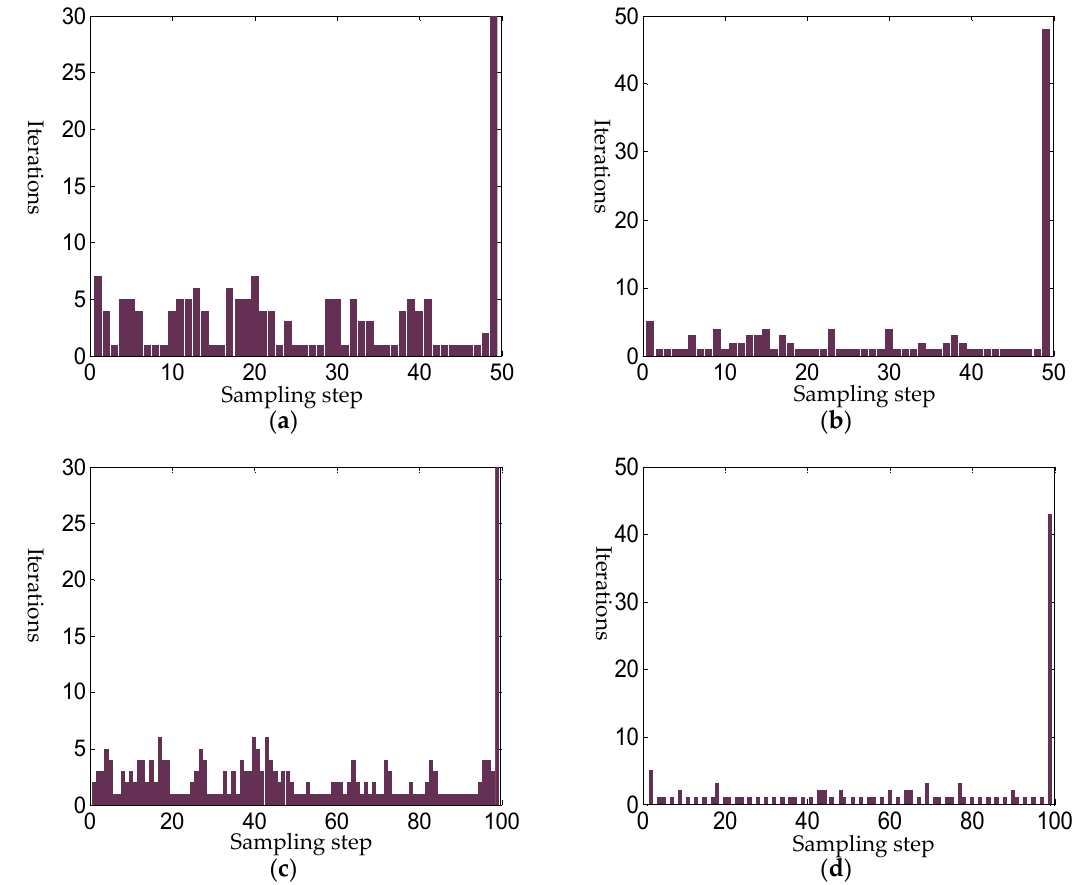
Figure 11. Iterations of the improved algorithm under different sampling conditions. ( a ) 50 steps uniform sampling tracking; ( b ) 50 steps periodic sampling tracking; ( c ) 100 steps uniform sampling tracking; ( d ) 100 steps periodic sampling tracking.